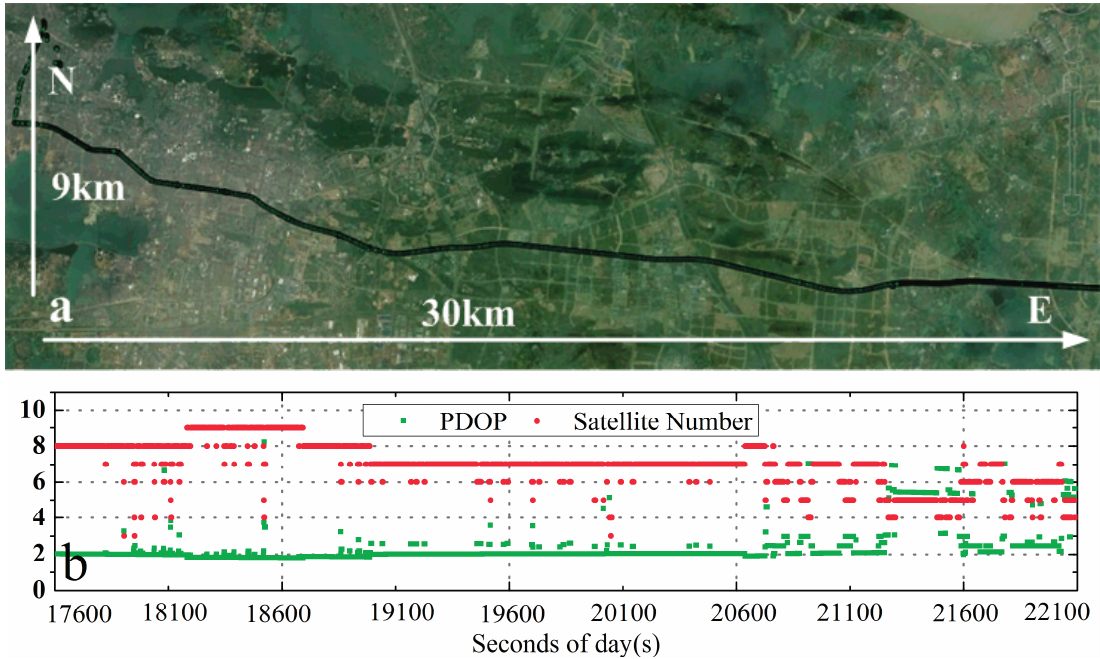
Figure 8. Trajectory of the vehicle-borne experiment ( a ) and number of satellites and PDOP ( b ) on 7 January 2012 in Wuhan, China.